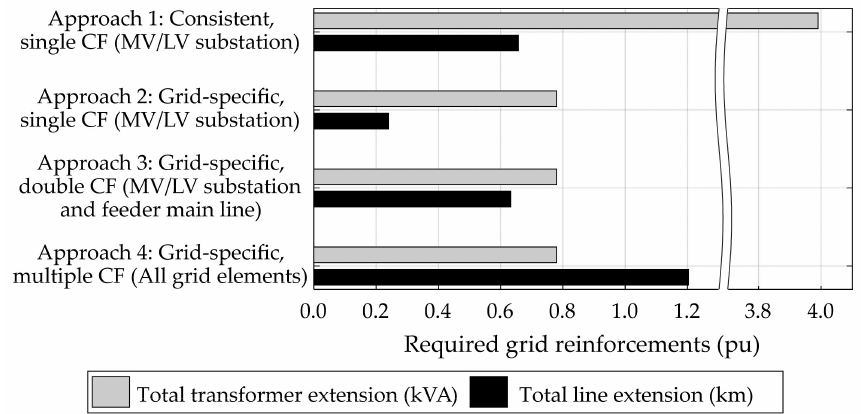
Figure 9. Comparison of different approaches to applying coincidence factors (CF) regarding the required transformer- and line extensions (7114 LV grids